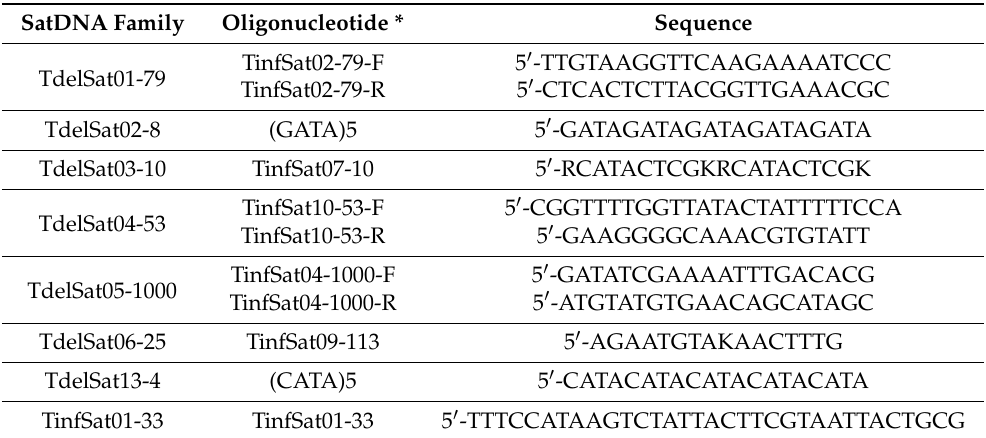
Table 1. Oligonucleotides used for FISH analyses in T. delpontei